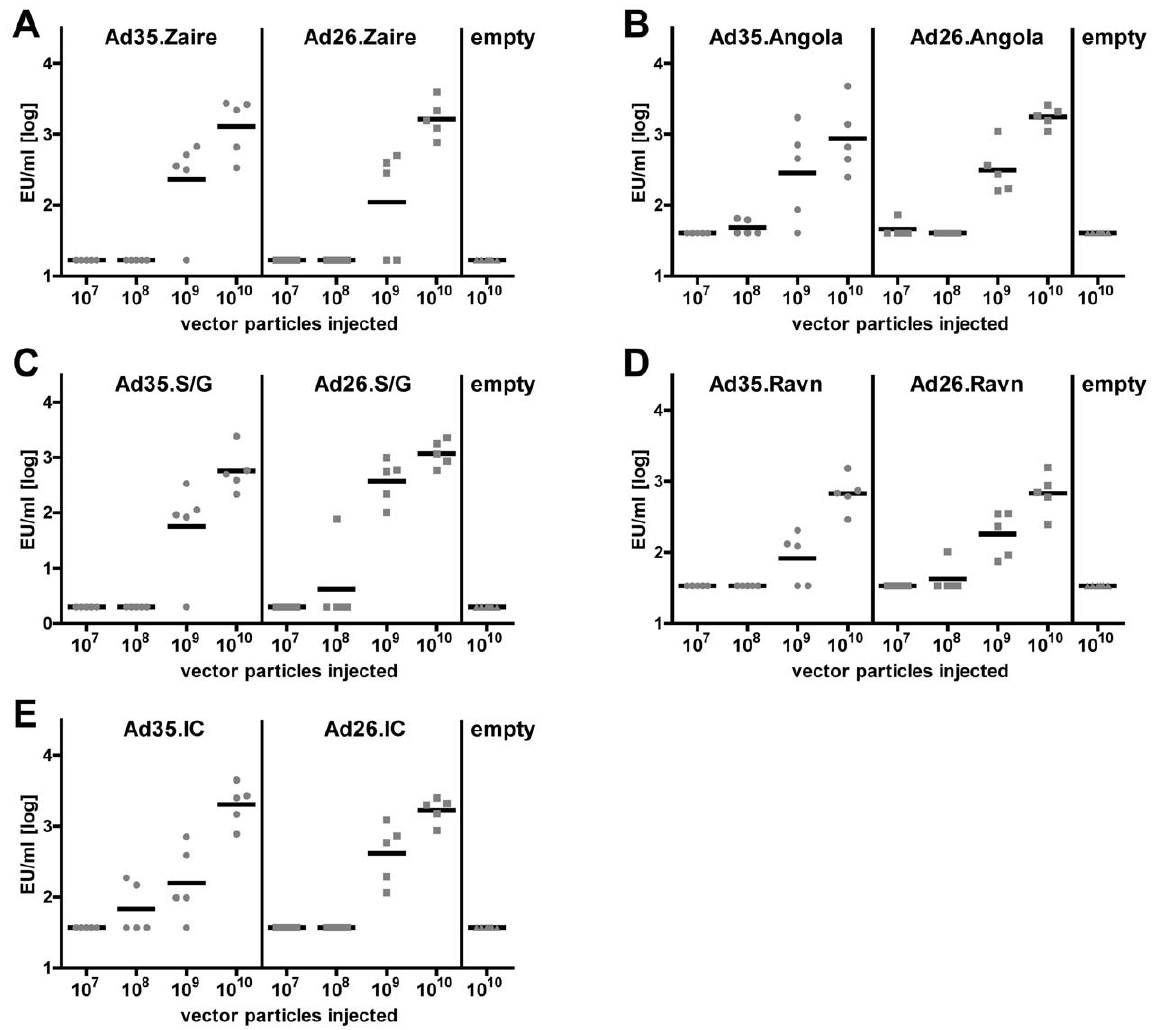
Figure 1. Dose dependent humoral immune response of filovirus rAd26 and rAd35 vectors. The filovirus specific humoral immune response was detected by ELISA from serum isolated from mice either vaccinated with 10 7 to 10 10 vp of rAd26 or rAd35 coding for Ebola Zaire (A), Ebola Sudan Gulu (C), Ebola Ivory Coast (E), Marburg Angola (B), or Marburg Ravn (D) glycoprotein (n=5 per dose, filovirus strain and serotype). For each individual experiment three mice each were immunized with rAd26 or rAd35 without a transgene in the E1 region. Arbitrary ELISA units/ml (EU/ ml) of serum samples were determined against a reference. The bar represents the mean of the log transformed EU/ml and the grey balls an individual